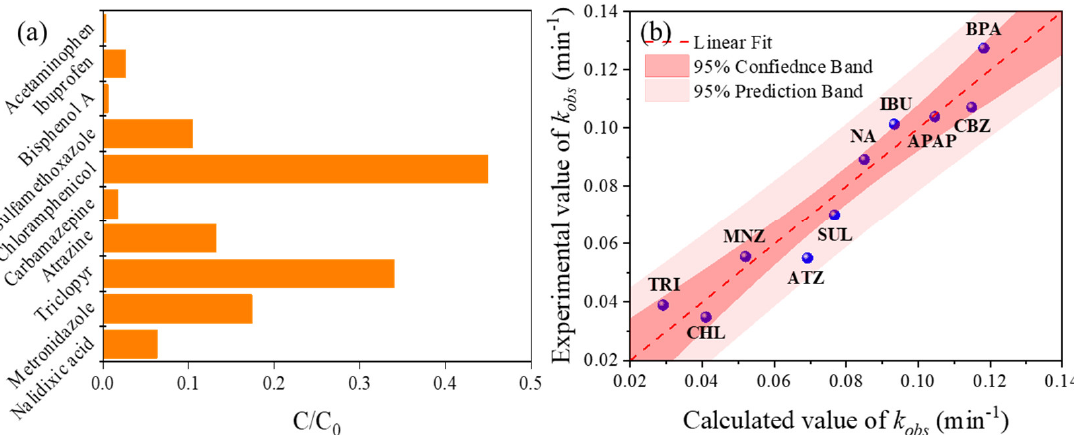
Figure 5. ( a ) The degradation efficiency of PPCPs in pyrite–CA–light system within 30 min. ( b ) Comparisons of calculated k obs to experimental values for PPCPs. Initial conditions: [pyrite] = 0.1 g L − 1 , [PPCPs] = 30 μM, [CA] = 0.6 mM, pH ini = 6.